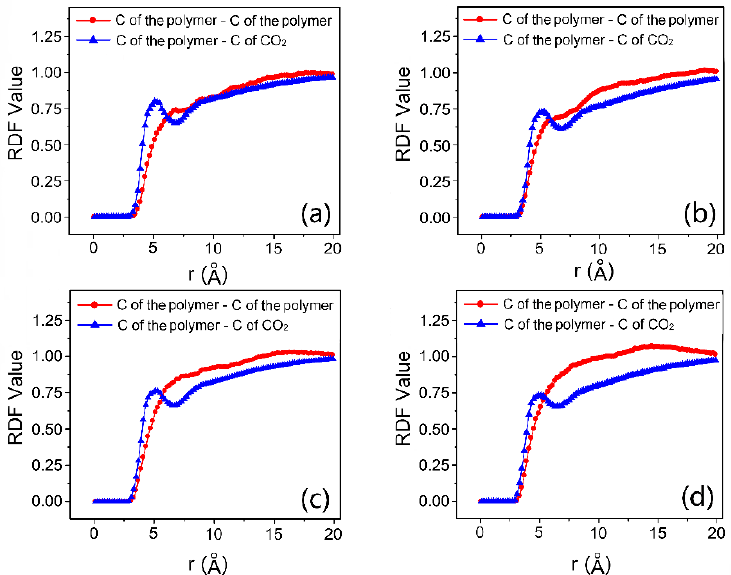
Figure 5. Intermolecular RDFs of the carbon-carbon pairs of polymer–polymer and polymer–CO 2 . ( a ) P(HFDA 0.87 - co -VBe 0.13 ); ( b ) P(HFDA 0.67 - co -VBe 0.33 ); ( c ) P(HFDA 0.50 - co -VBe 0.50 ); ( d ) P(HFDA 0.29 - co -VBe 0.71 ).